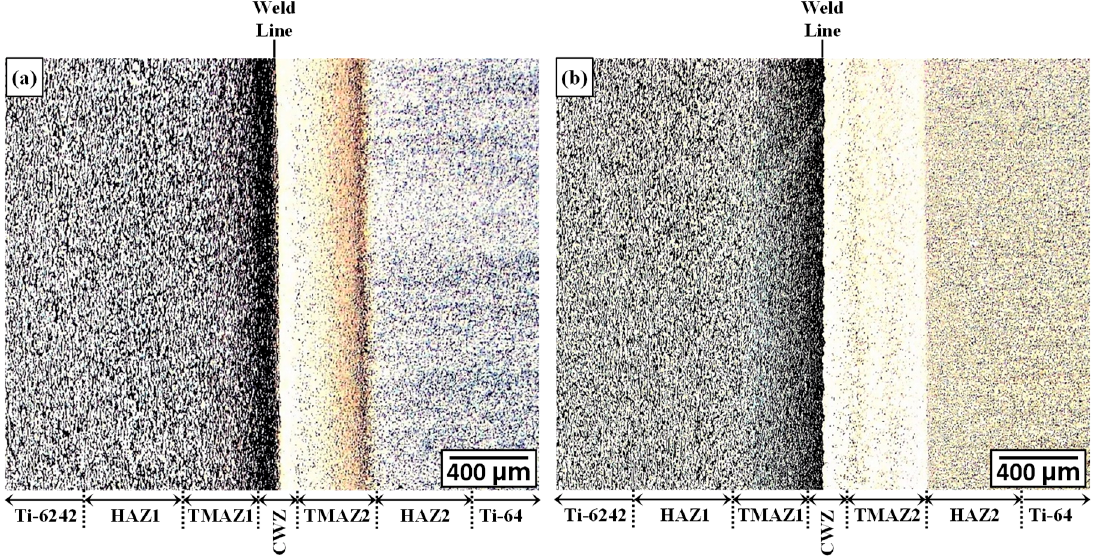
Figure 4. Optical Microscope (OM) images showing the different regions across the dissimilar Ti-64-Ti-6242 welds: ( a ) as-welded (AWed) and ( b ) stress relief annealed (SRAed) conditions.